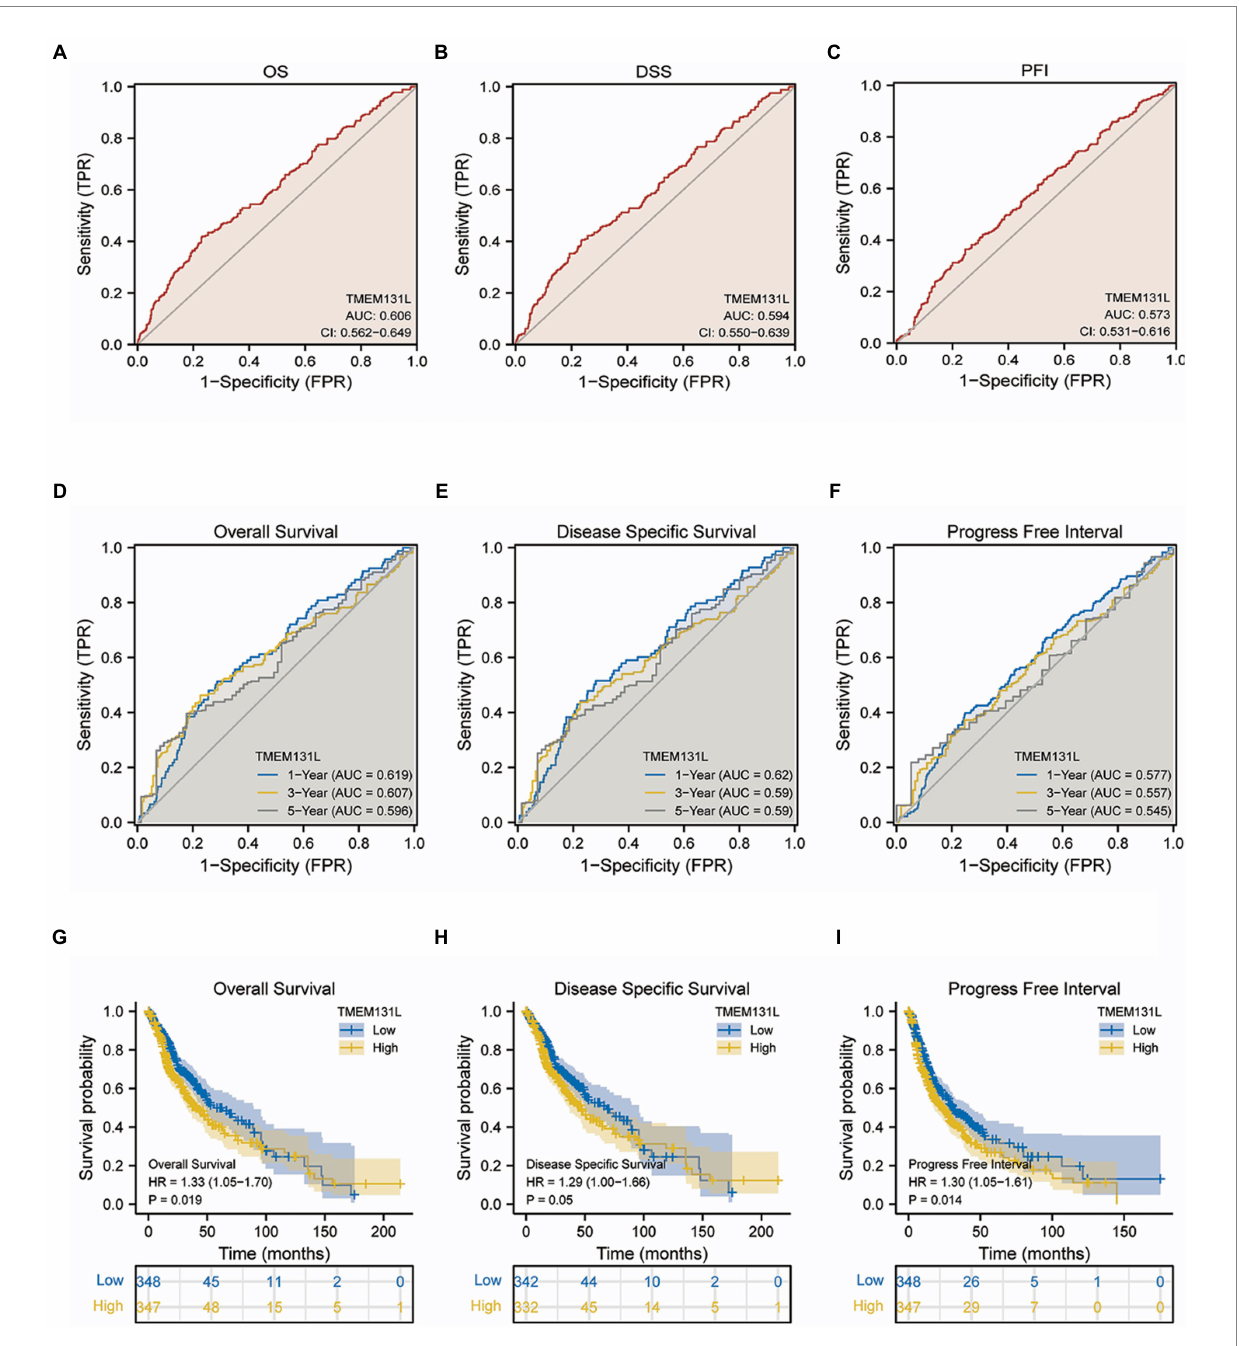
FIGURE 5 Identification and survival analysis of TMEM131L for poor prognosis of OS, PFI, and DSS in GCB and LGG patients. (A–C) Differential survival of TMEM131L in OS, PFI, and DSS in GCB&LGG patients ; (D–F) Time-dependent ROC curves of TMEM131L for 1, 3, and 5-year OS, DSS, and PFI in patients with GCB&LGG; (G–I) Kaplan–Meier survival analysis curve of different survival status of GCB&LGG patients with OS, PFI and DSS based on the expression of